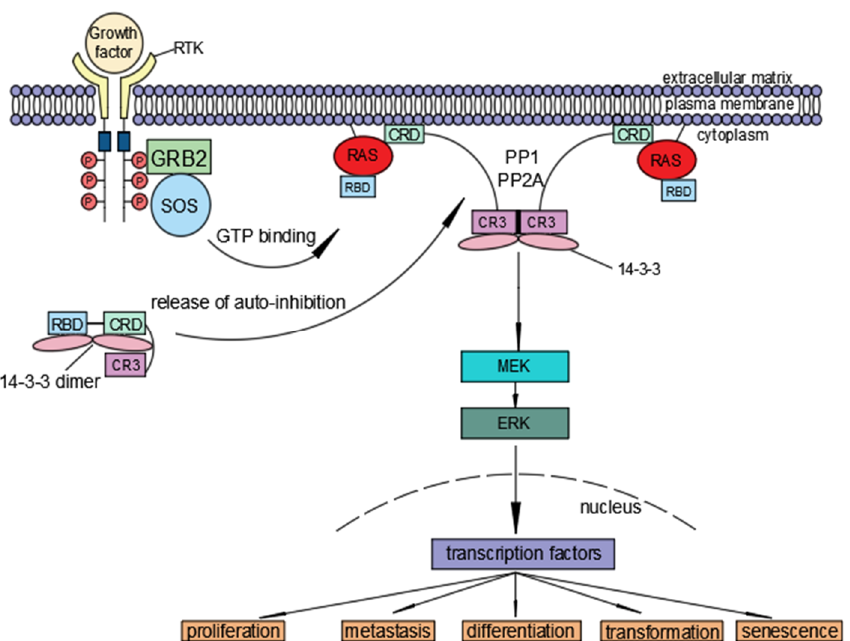
Figure 2. The Ras/Raf/MEK/ERK signaling cascade. Growth factor binds to receptor tyrosine kinase and activates growth-factor receptor-bound 2 (GRB2) and Son of Sevenless (SOS) to load GTP to Ras. Then, Ras-GTP recruits Raf to the plasma membrane where Raf is activated, leading to sequential phosphorylation and activation of MEK and ERK. Activated ERK then phosphorylates a variety of substrates and elicits various cellular responses. RBD-CRD-CR3 designates essential domains of Raf and CR3 is the kinase